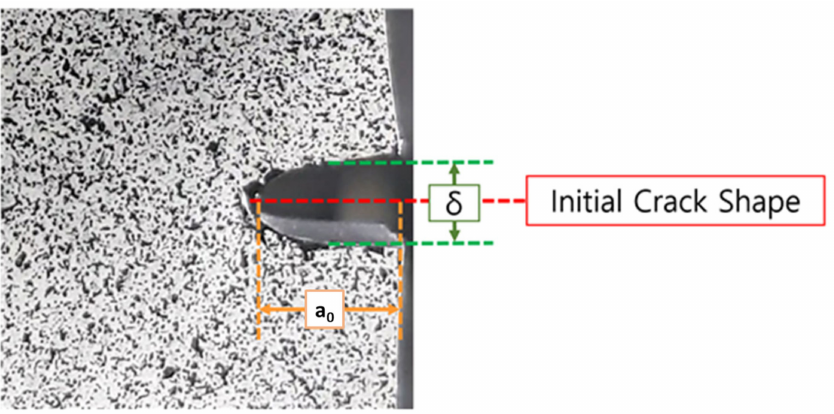
Figure 2. Crack tip opening displacement (CTOD).